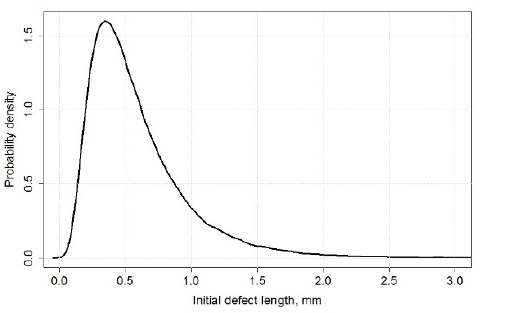
Figure 3. Initial crack length distributions and corrosion rate lognormal distribution parameters for length: location = − 0.7, scale = 0.6; for rate: location = − 1.33, scale = 0.5.